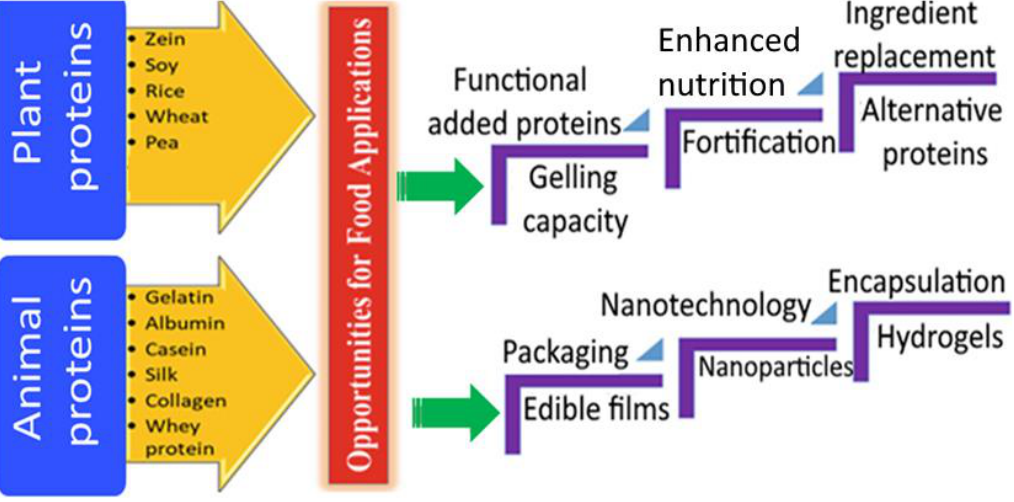
Figure 1. Different types of plant- and animal-based ingredients as gelling agents in the food industry. Figure 1 is reprinted with permission from Munir et al. [15] (Copyright © 2022 by authors).